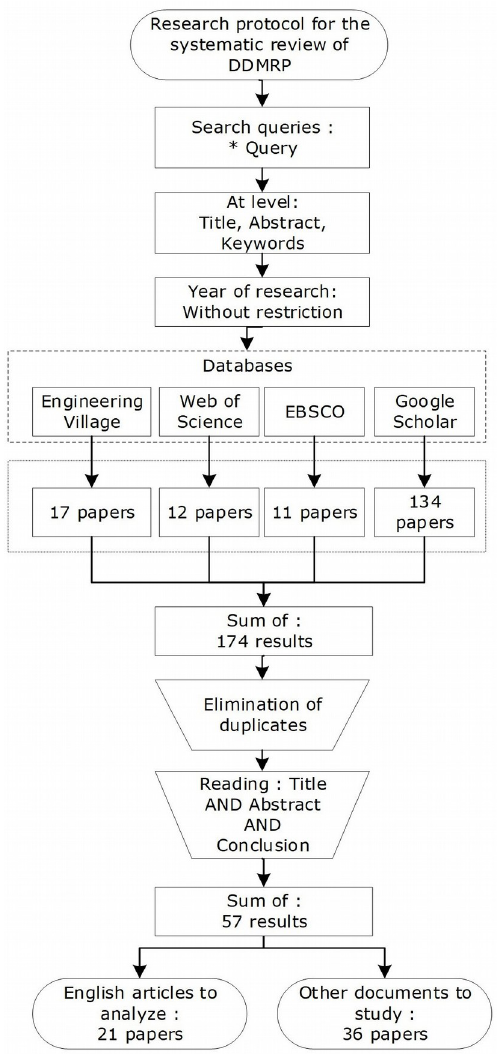
Figure 1. The research protocol for a systematic literature review of